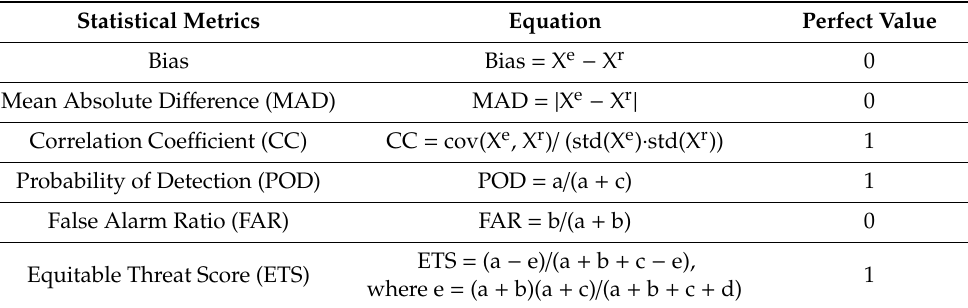
Table 2. Statistical metrics used in this study 1 .